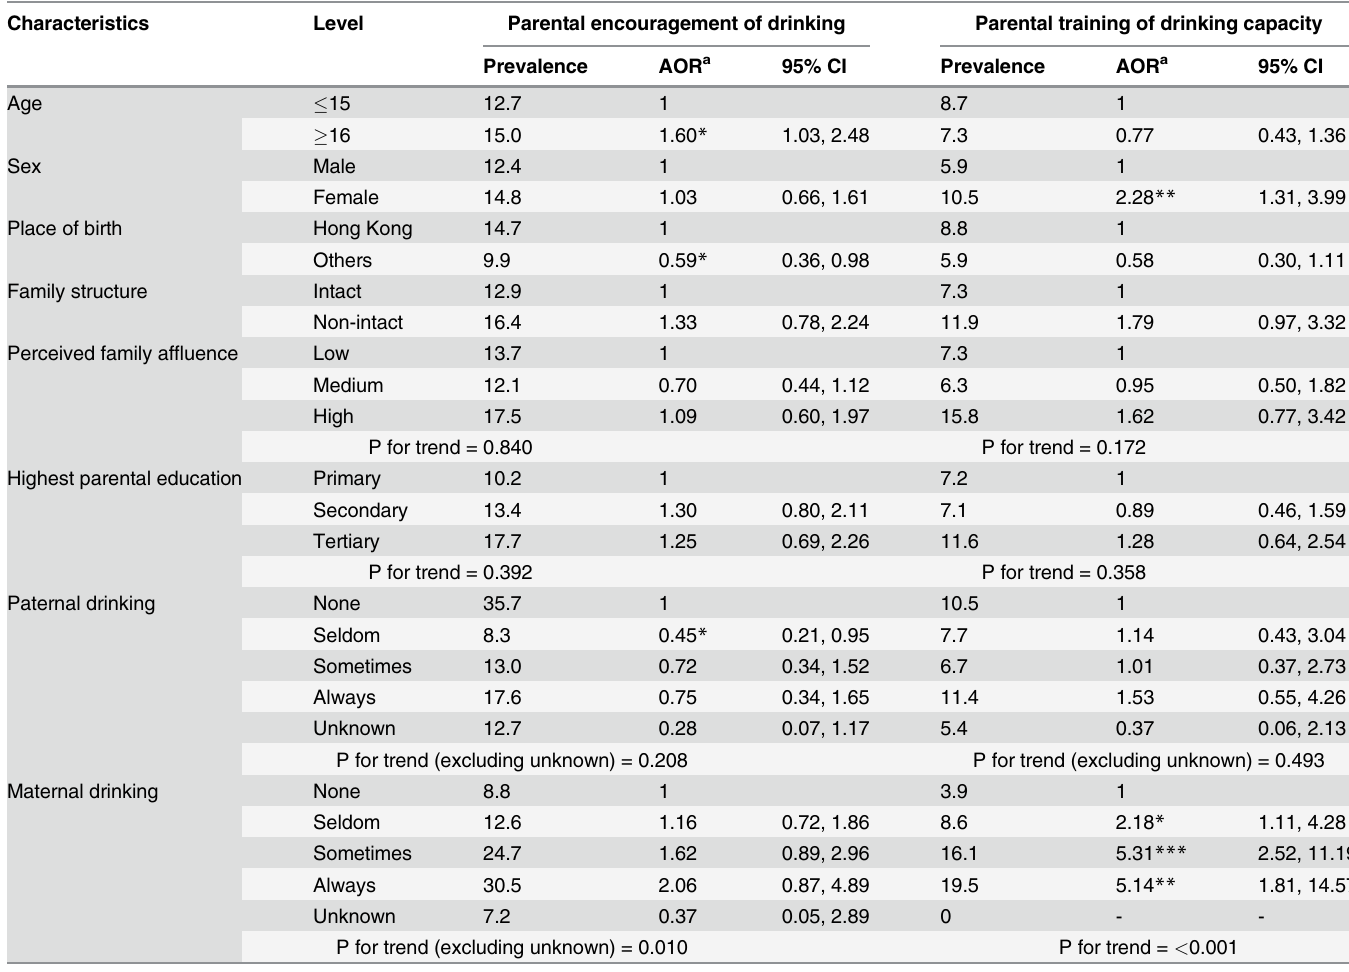
Table 5. Prevalence and adjusted odds ratios (AORs) for parental encouragement of drinking and training of drinking capacity.